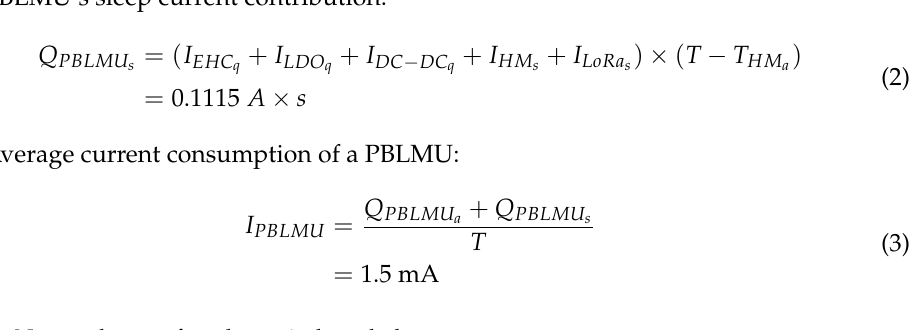
Table 2. Nomenclature of mathematical